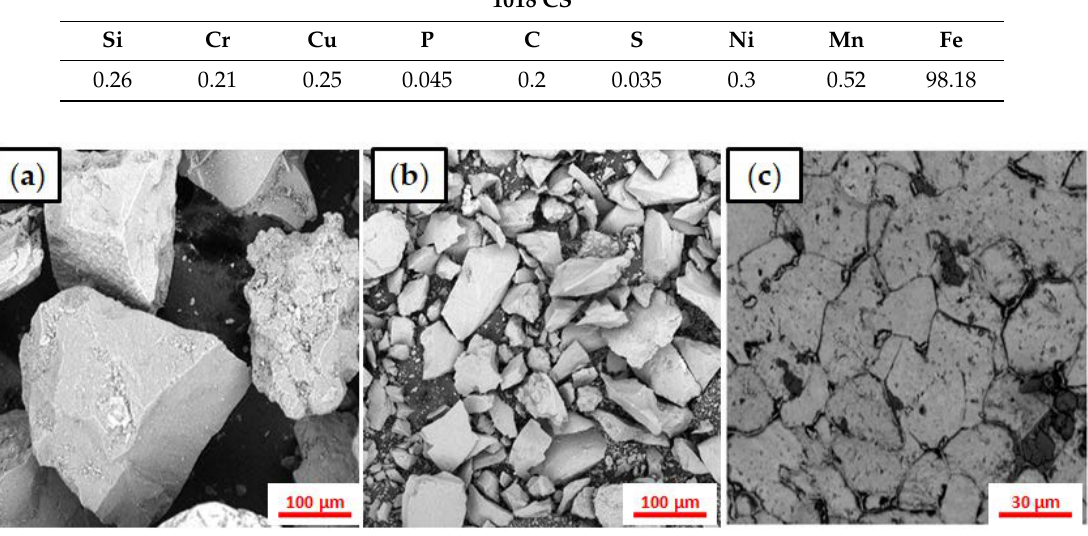
Figure 2. Microstructures of ( a ) 450 µ m sand, ( b ) 50 µ m sand fines and ( c ) 1018 CS.